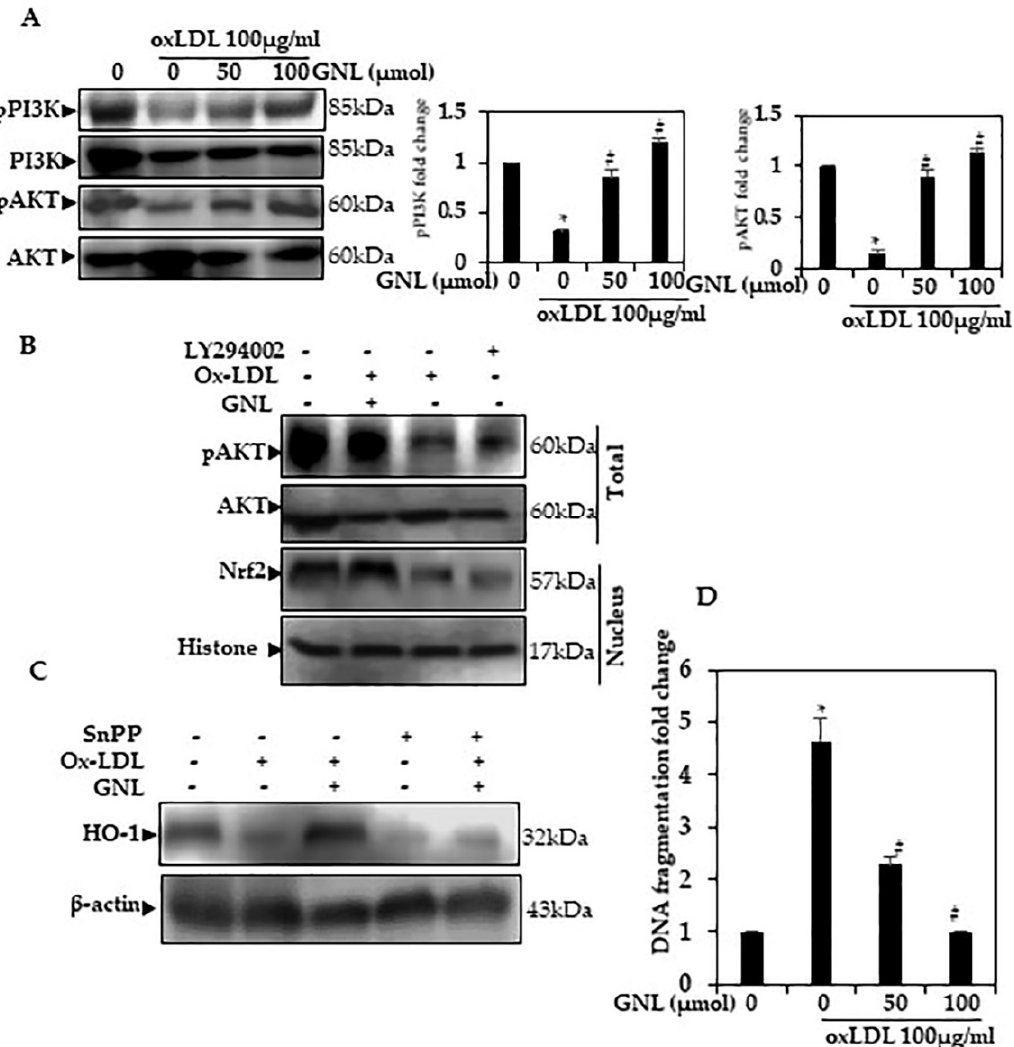
Figure 7. GNL activates PI3K/AKT phosphorylation. ( A ) The cells were treated with Ox-LDL (100 µg/mL) or GNL (0, 50 and 100 µmol) for 24 h. Based on Western blots, GNL has an impact on anti-pPI3K and anti-pAKT. Th relative ratios of PI3K and AKT expression are listed in the Western blotting results. ( B ) Cells were pretreated for two hours with PI3K/AKT inhibitors, and then with GNL (100 mol) and/or Ox-LDL (100 g/mL) for 24 h. By using anti-pAKT and anti-Nrf2,